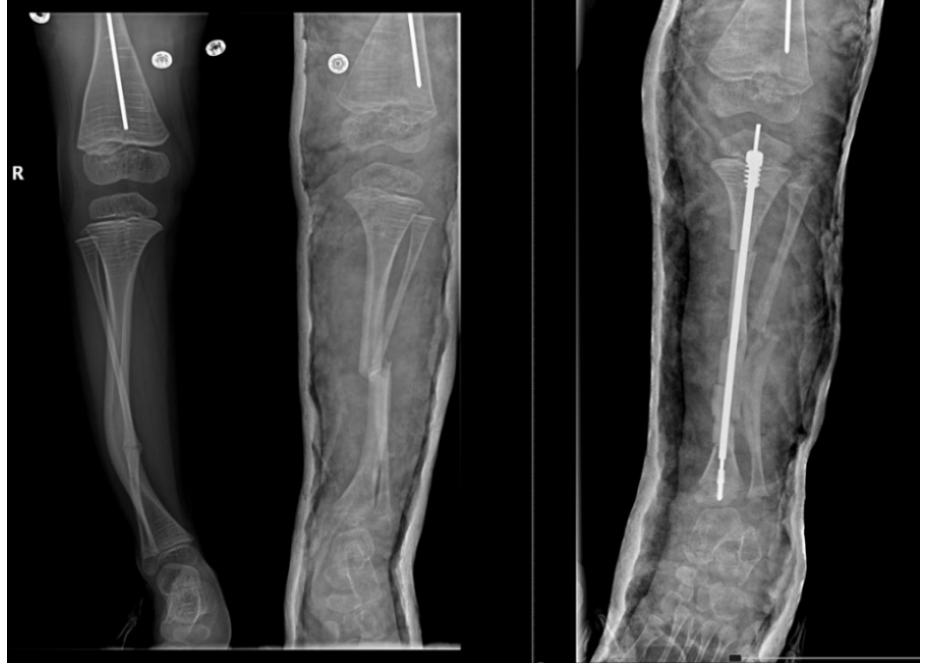
Figure 3. Before and after surgery aspects for a study participant.